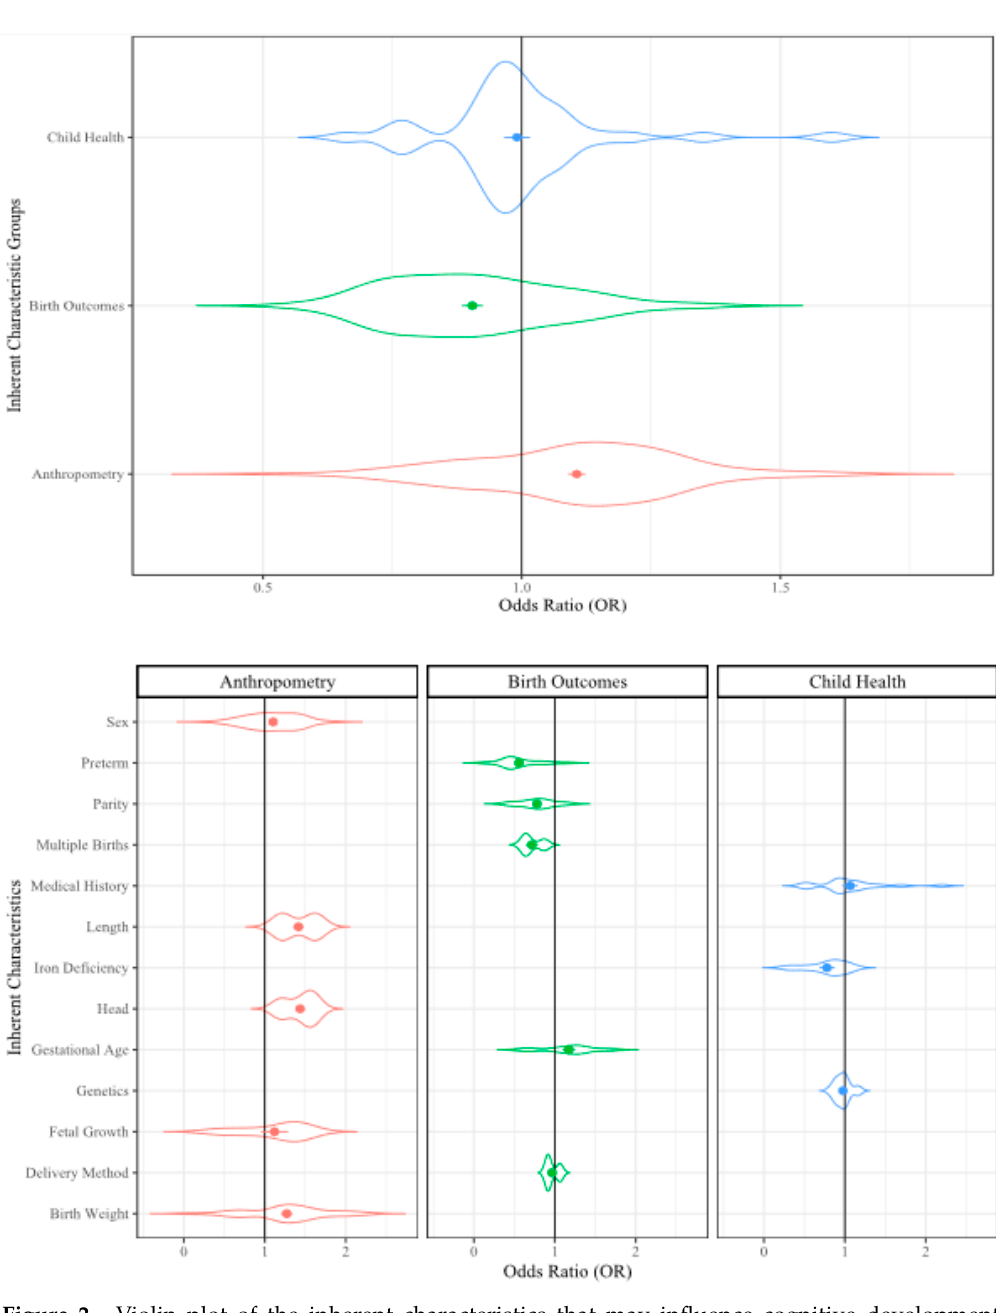
Figure 2. Violin plot of the inherent characteristics that may influence cognitive development. Violin width represents the distribution of the Odds Ratios (OR), the height represents density of the ORs; dots represent mean OR, error bars represent mean SE.